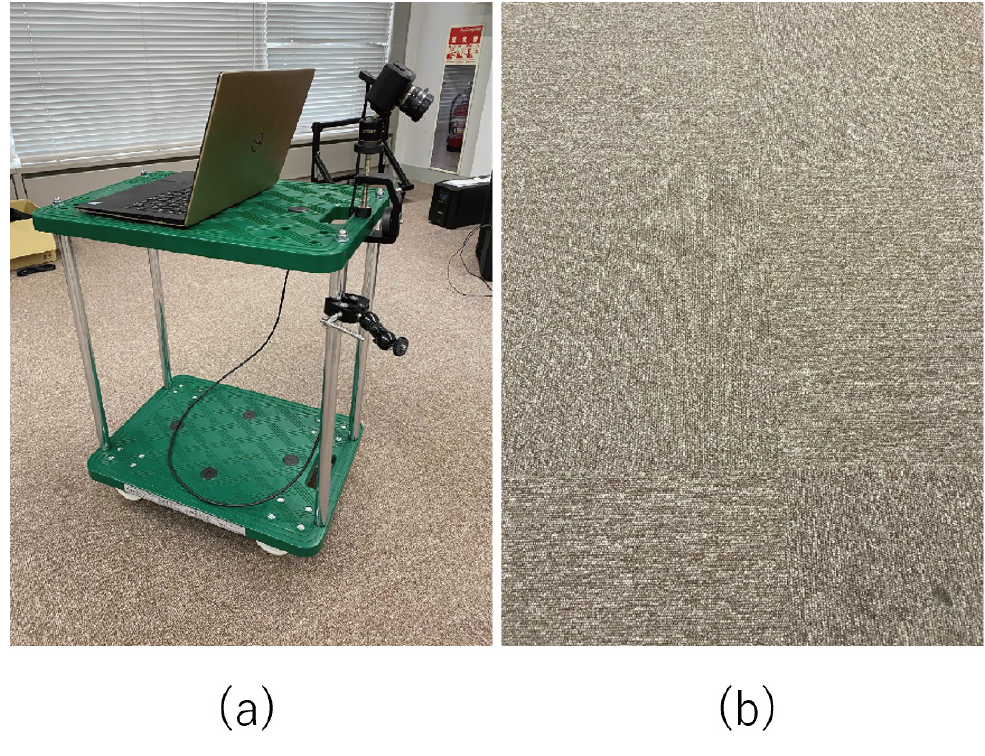
Figure 10. ( a ) Experimental setup. An event camera was mounted on a dolly at an angle (not parallel) to the surface of interest. ( b ) Carpeted surface; it would be difficult to extract its features with a normal